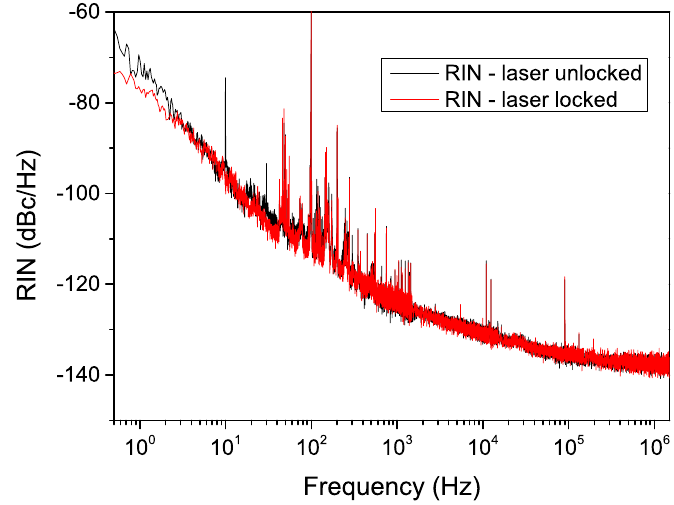
Figure 5. RIN spectral distribution in locked and unlocked